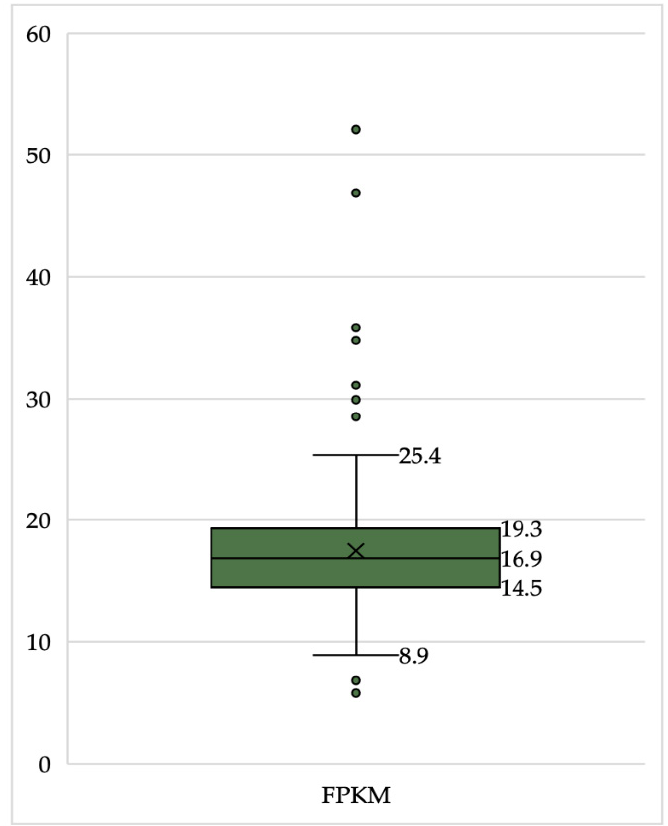
Figure 2. A box plot demonstrating the expression of FPKM (quantification of CDK4) in 173 pancreatic ductal adenocarcinoma patients. Interquartile range, median and upper/lower bounds shown.